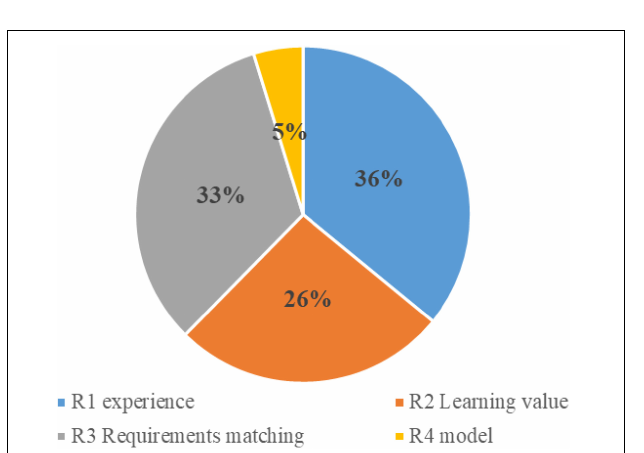
FIGURE 1 | The percentage of secondary policy usage in attention strategy.